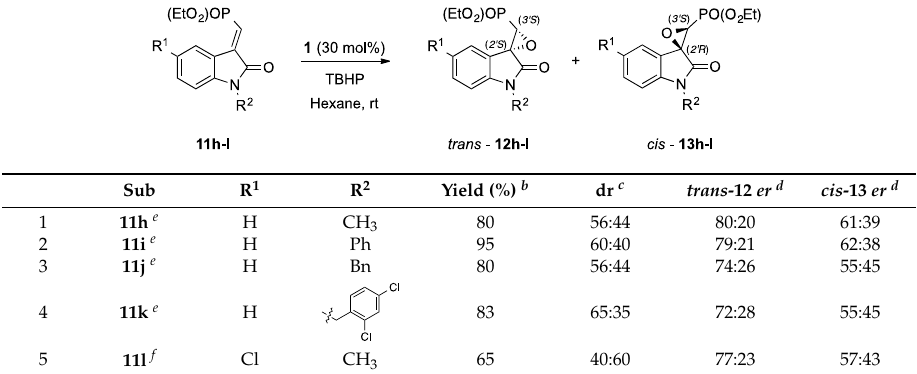
Molecules 2018 , 23 , x Molecules 2018 , 23 , x Table 2. Substrate scope of the organocatalytic epoxidation on α -ylideneoxindoles 11h – l bearing a Table 2. Substrate scope of the organocatalytic epoxidation on α -ylideneoxindoles 11h – l bearing Table 2. Substrate scope of the organocatalytic epoxidation on α -ylideneoxindoles 11h – l bearing a Table 2. Substrate scope of the organocatalytic epoxidation on α -ylideneoxindoles 11h – l bearing a PO(OEt) 2 moiety as the EWG group of the exocyclic double bond a . a PO(OEt) 2 moiety as the EWG group of the exocyclic double bond a . PO(OEt) 2 moiety as the EWG group of the exocyclic double bond a .